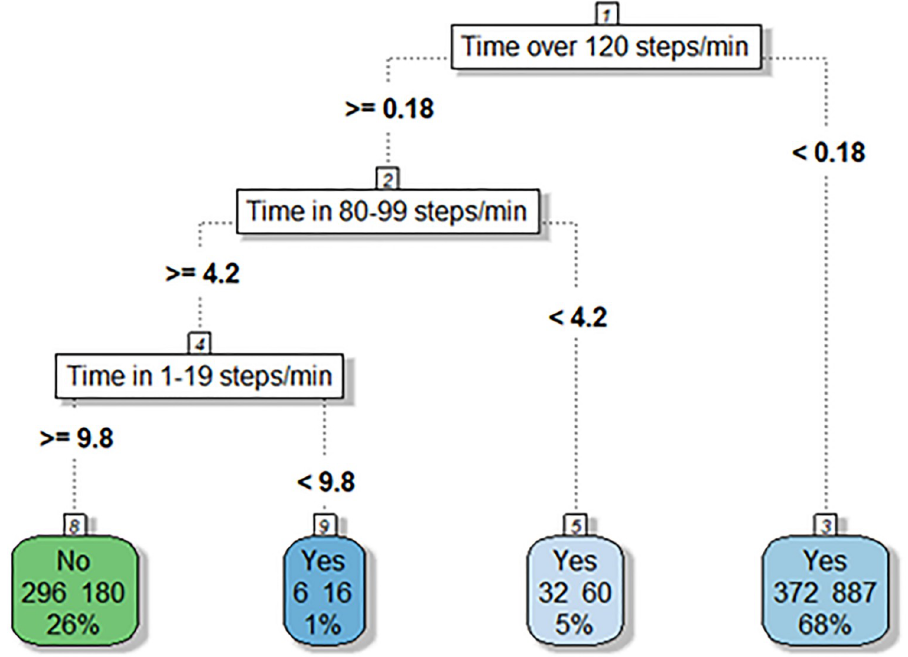
Fig 2. Decision tree classifying low-risk metabolic syndrome by thresholds of time spent in minutes in each cadence band. The value “No” represents absence of risk and “Yes” represents presence of risk. In each box, the values on the left are the number of participants in the box that did not have the risk factor and the value on the right are the number of participants who did have the risk factor. The percentage represents what percent of the total population were contained in the box. Spending virtually no time in cadence band 7 (120 steps/min) would result in a person being classified as at-risk. The only pathway that exists to be classified as not being at-risk is to spend time in